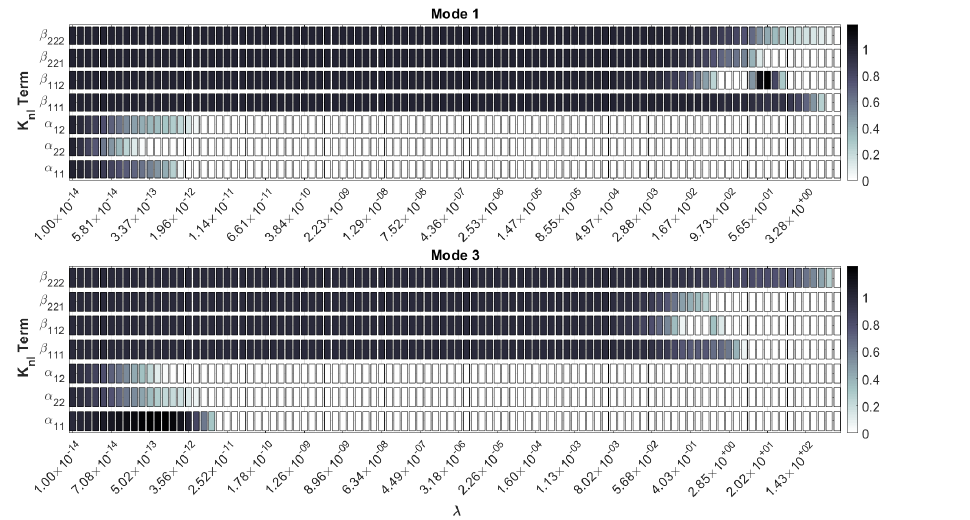
Figure 4. Nonlinear stiffness coefficients of the first and third modal equations versus the least absolute selection and shrinkage (LASSO) regularization parameter λ . The nonlinear stiffness coefficients were normalized with respect to the values estimated using least